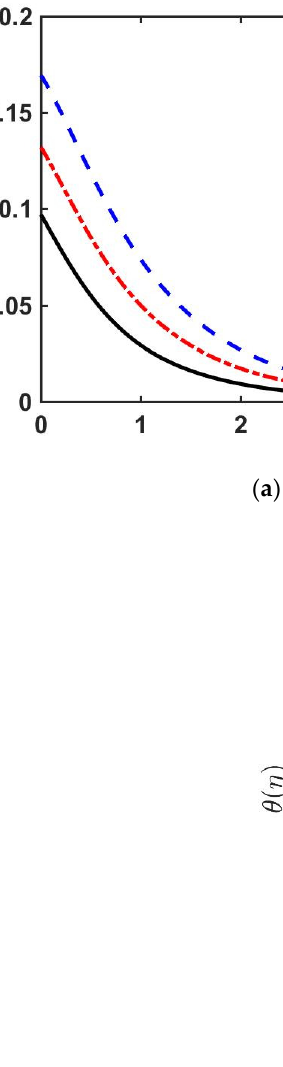
Figure 10. Effect of Ec on θ ( η ) .